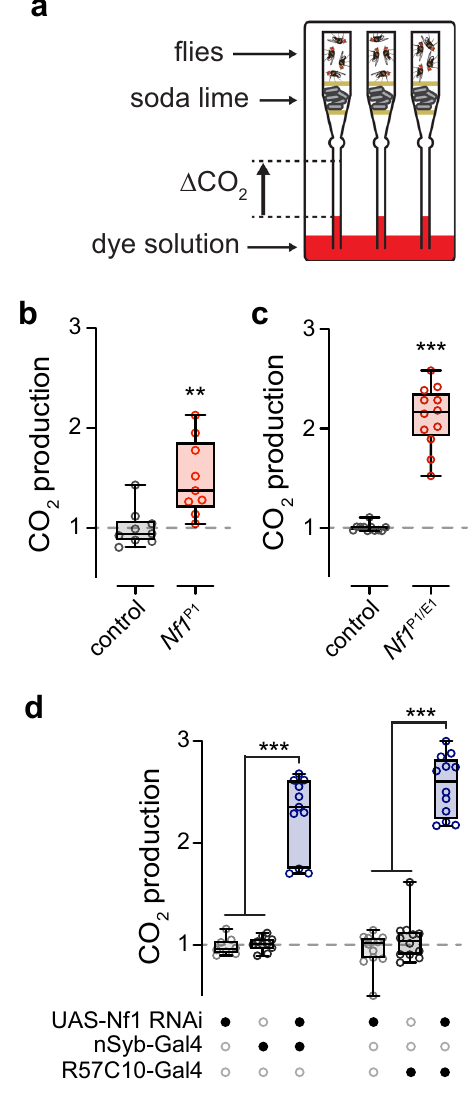
Fig. 1 Loss of Nf1 increases CO 2 production via neuronal mechanisms. a Diagram of respirometry apparatus. b Normalized CO 2 production in Nf1 P1 mutants and w CS10 controls. ** p = 0.002 (Mann – Whitney, two-sided; n = 9). c Normalized CO Nf1 P1 / E1 mutants 2 production in heteroallelic ( n = 12) and controls ( n = 11). *** p < <0.0001 (Mann – Whitney, two-sided). d Normalized CO 2 production when Nf1 was knocked down with RNAi driven by pan-neuronal Gal4 lines: nSyb- and R57C10-Gal4. Gal4/ + and UAS/ + are heterozygous controls. *** p < 0.001 (Dunn ’ s test, two-sided; for nSyb-Gal4: n = 8 UAS-Nf1 RNAi/ + , n = 10 nSyb-Gal4/ + , n = 11 experimental group. For R57C10-Gal4: n = 12 per genotype). Each “ n ” = single respirometer (containing 4 animals). Box plots — box: 1st to 3rd quartiles, median: line, whiskers: min – max, individual data points: